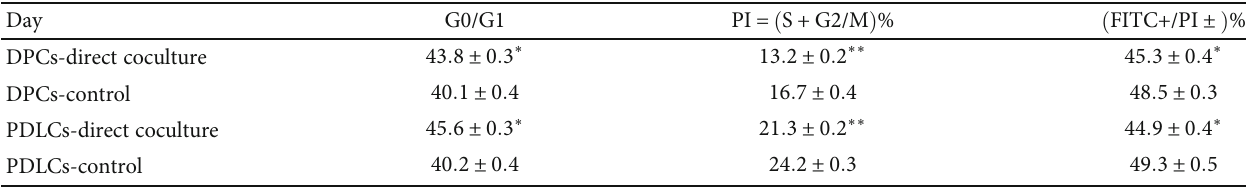
Table 3: The cell cycle and apoptosis of PDCs and PDLCs with direct coculture at 3 d ( mean ± SD % ; N = 3